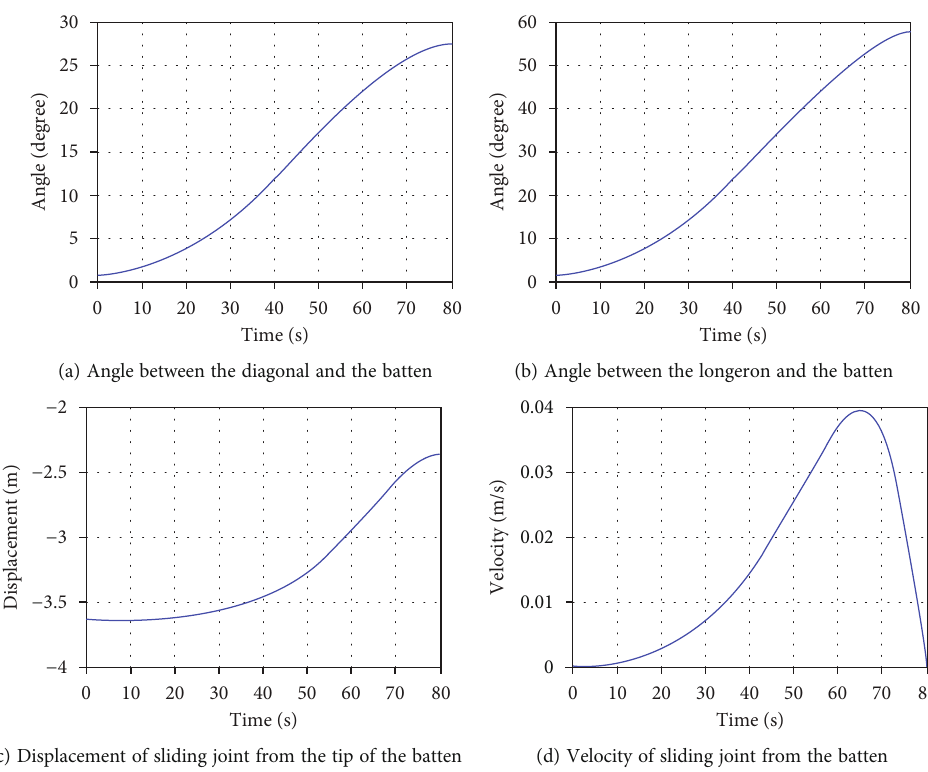
Figure 11: Simulation results of the truss deployment in the fi rst stage.